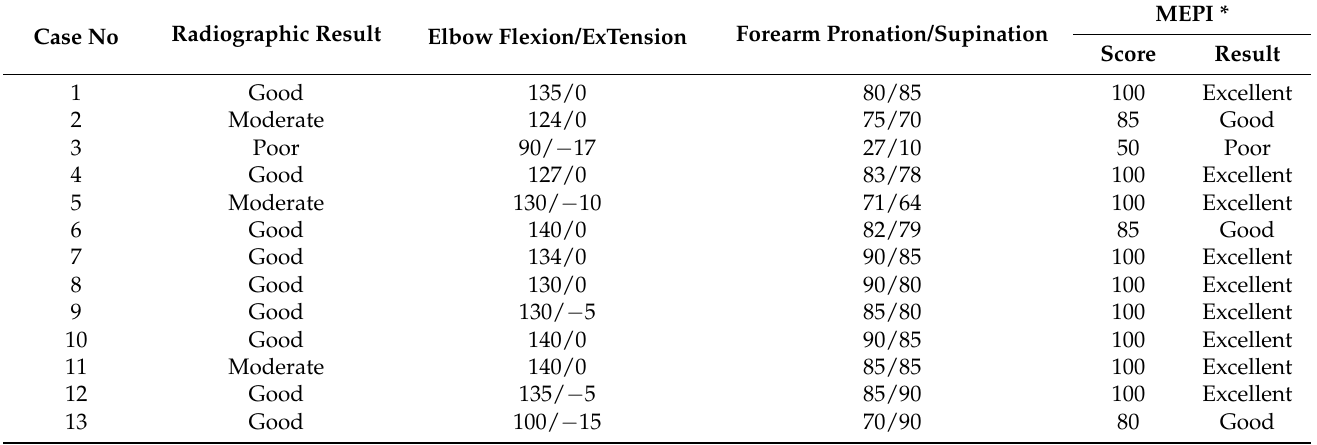
Table 2. Radiographic and clinical results.